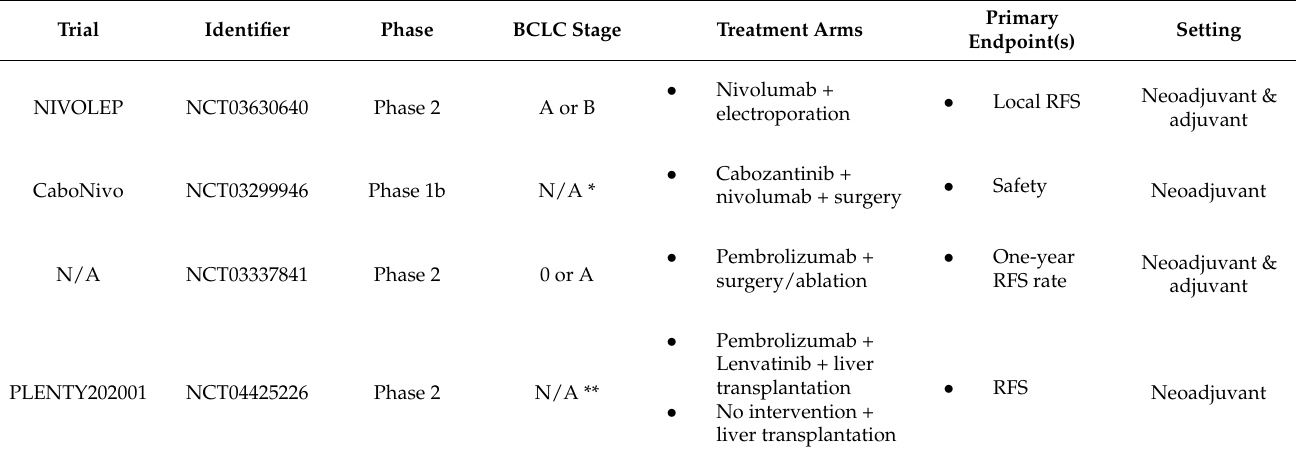
Table 5. Current clinical trials on neoadjuvant systemic